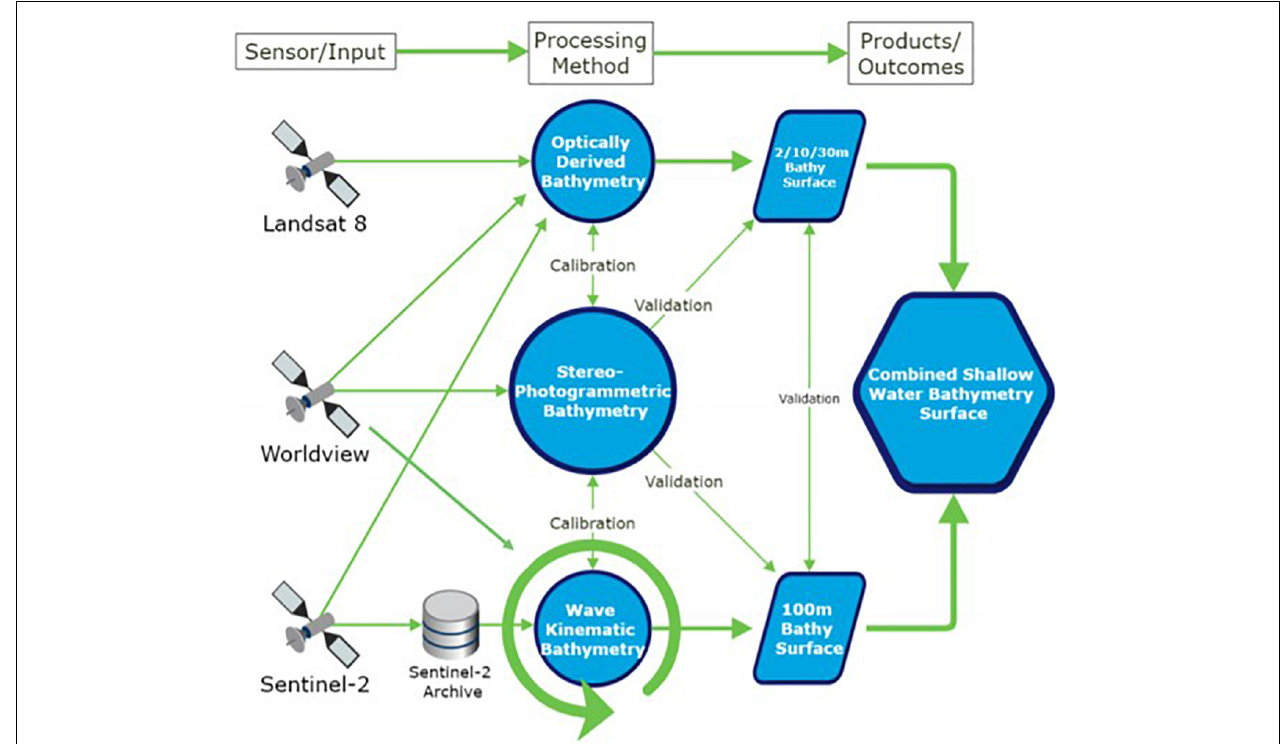
FIGURE 5 | TCarta’s Project Trident Processing Scheme. From Goodrich